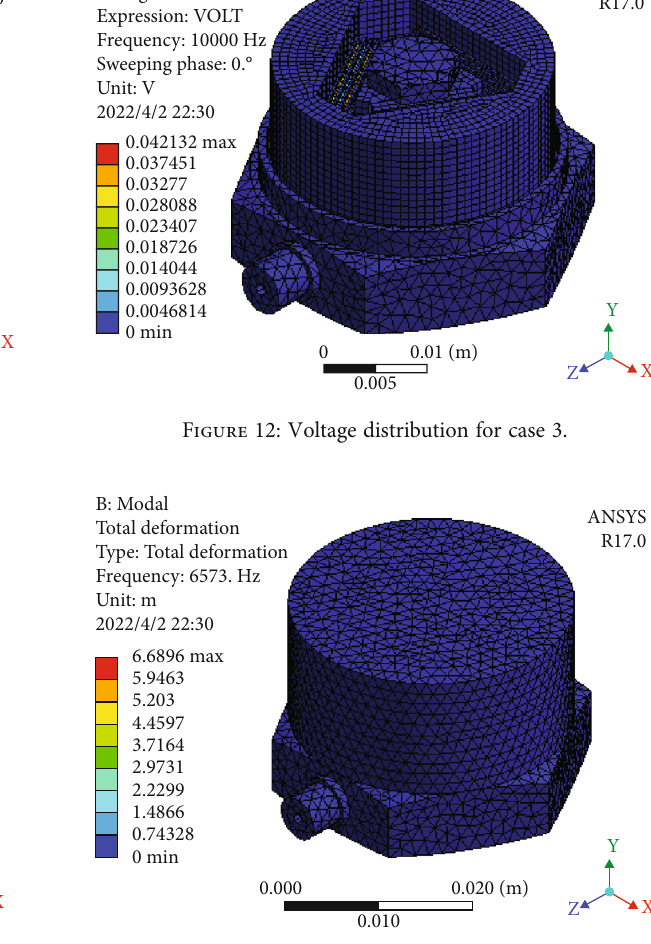
Figure 13: Modal analysis result for case 3.